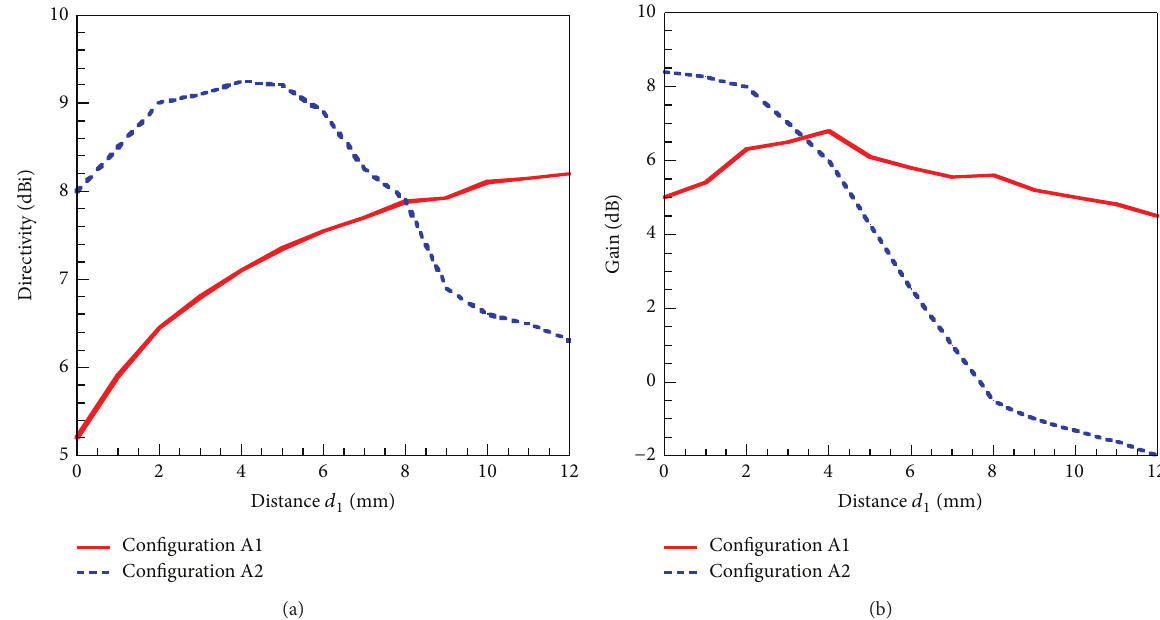
Figure 5: Effect of the coupling distance 𝑑 1 at the frequency 𝐹 𝑅 , on the simulated directivity (a) and gain (b), for configurations A1 ( 𝐹 𝑅 = = 1.75 GHz). 1.55 GHz) and A2 ( 𝐹 𝑅